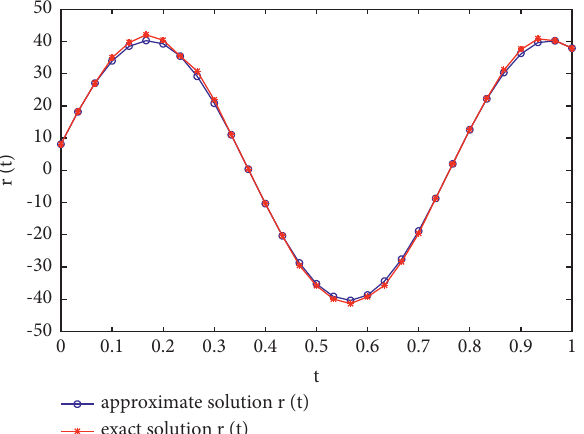
Figure 2: Reconstructions of r ( t ) of Example